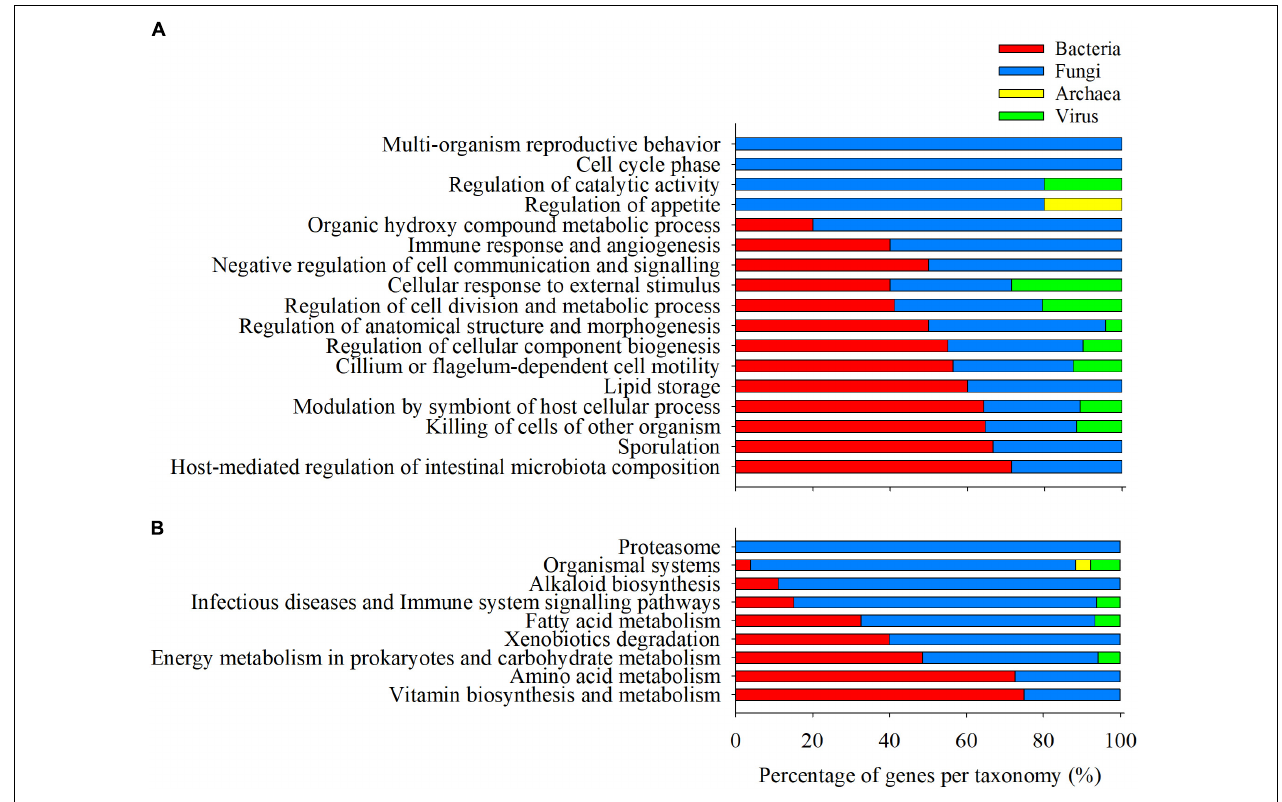
FIGURE 6 | Barplot representing the relative abundance of Bacteria (red), Fungi (blue), Archaea (yellow), and Virus (green) transcripts within the fraction of genes allocated to each enriched and clustered GO-BP (A) and KEGG (B)